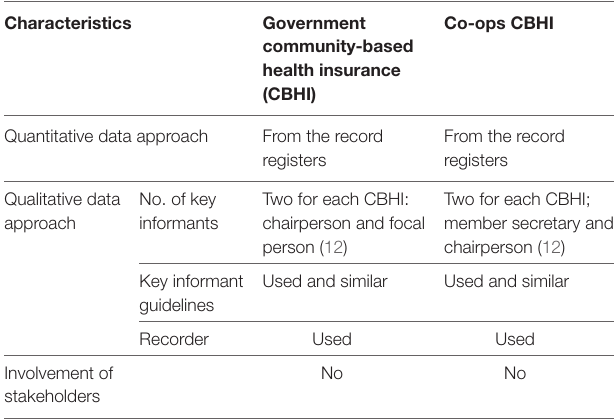
TaBle 1 | Characteristics of data and respondents.